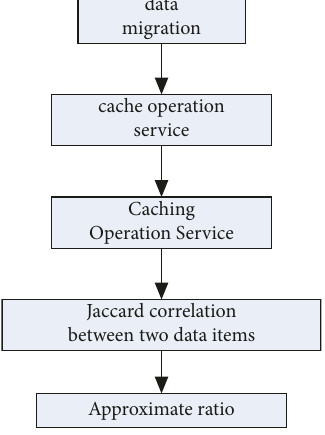
Figure 5: Data migration